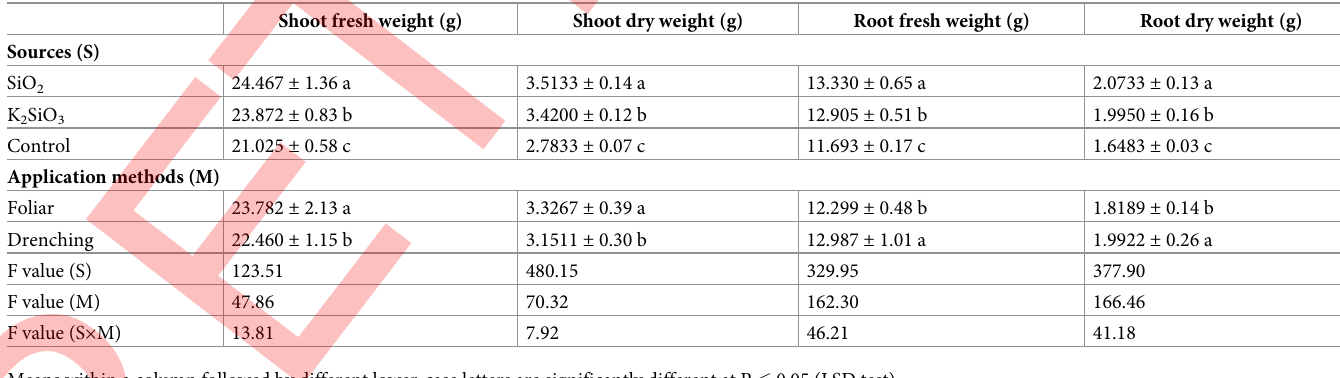
Table 4. Effect of Si sources and Si application methods on shoot fresh weight (g) shoot dry weight (g), root fresh weight (g), and root dry weight (g) of maize